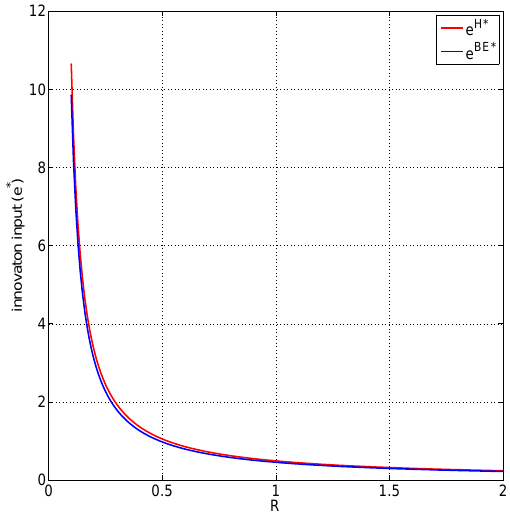
Figure 15. The influences of R on the innovation input e .